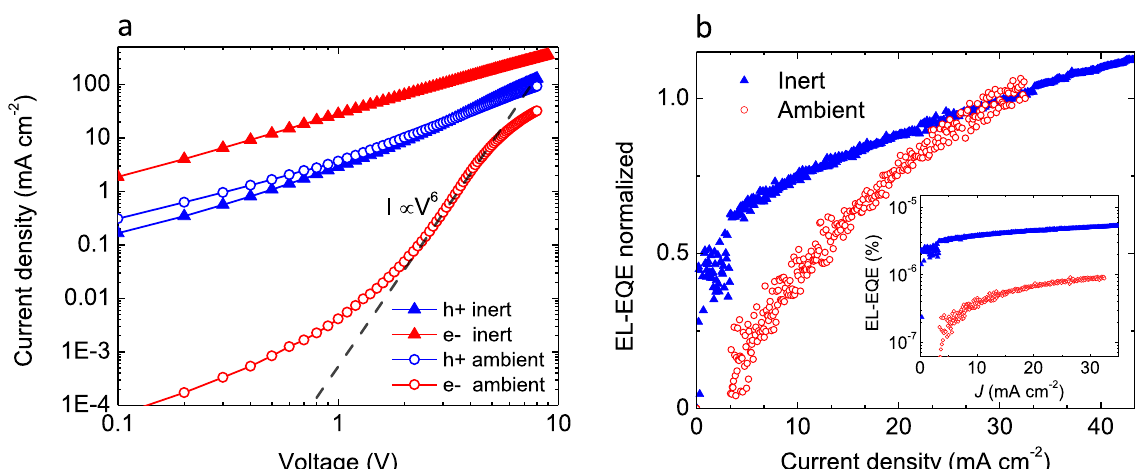
Fig. 5 Carrier transport a SCLC plot of laminated hole-only (blue) and electron-only (red) devices processed inert and exposed to ambient for 2 ( fi lled triangles) and 45 (open circles) minutes. b EL-EQE vs. injected current-density for a laminated TQ1:PC 71 BM device processed inert (blue triangles) and exposed to ambient for 45 min (red